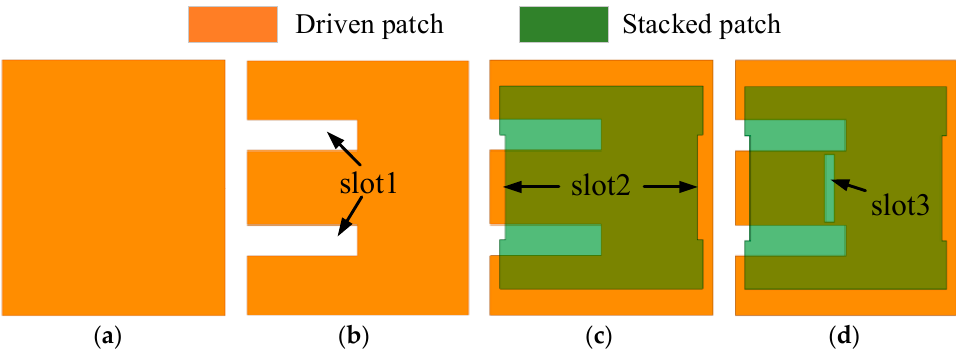
Electronics 2023 , 12 , 1331 Figure 3. Reference antennas . ( a ) Ant1; ( b ) Ant2; ( c ) Ant3 and ( d ) the proposed antenna. Figure 3. Reference antennas. ( a ) Ant1; ( b ) Ant2; ( c ) Ant3 and ( d ) the proposed antenna.